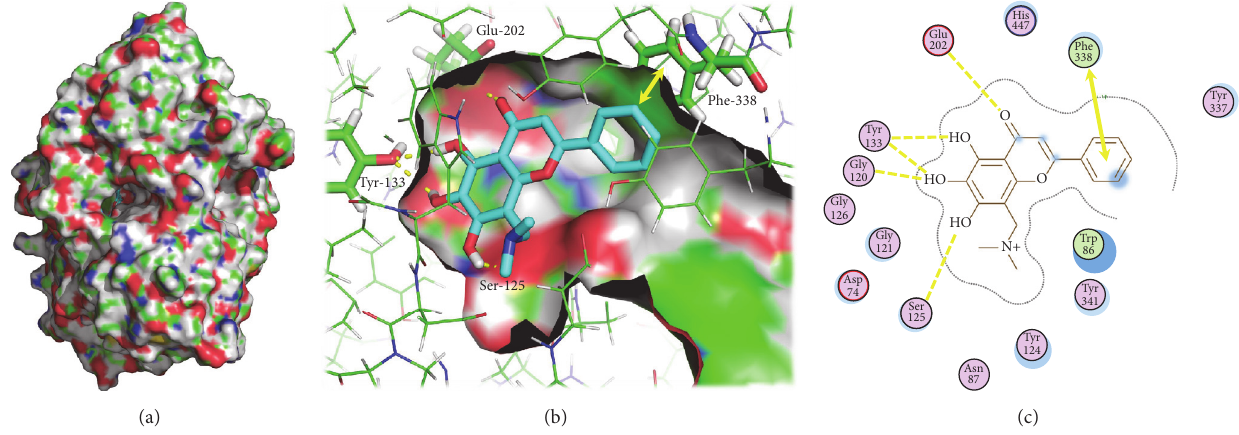
Figure 2: (a) AChE (surface) and docked 14 (blue sticks). (b) AChE active site (surface) bound to 14 (blue sticks). Residues involved in hydrogen interactions (yellow broken line) and 𝜋 stacking interactions (yellow double arrow) are displayed using a stick model. AChE carbon, oxygen, nitrogen, and hydrogen are represented in green, red, blue, and grey, respectively. (c) 2D depiction of the 14 docked into the binding site of AChE highlighting the protein residues that form the main interactions with the different structural units of the inhibitor. Hydrogen-bonding interactions are represented with yellow broken lines. 𝜋 stacking interactions are represented with a yellow double arrow. Receptor residues that are close to 14 , but whose interactions with the ligand are weak or diffuse, such as collective hydrophobic or electrostatic interactions, are also represented (all the ones that have no indication for hydrogen-bonding or 𝜋 stacking). Hydrophobic residues are colored with a green interior, polar residues are colored in light purple, basic residues are annotated by a blue ring, and acidic residues are annotated with a red ring. Solvent accessible surface area of 14 is plotted directly onto the atoms in the form of a blue